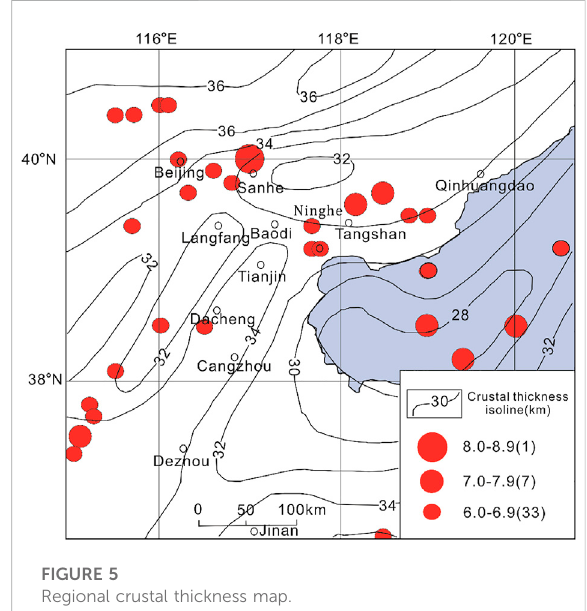
FIGURE 5 Regional crustal thickness